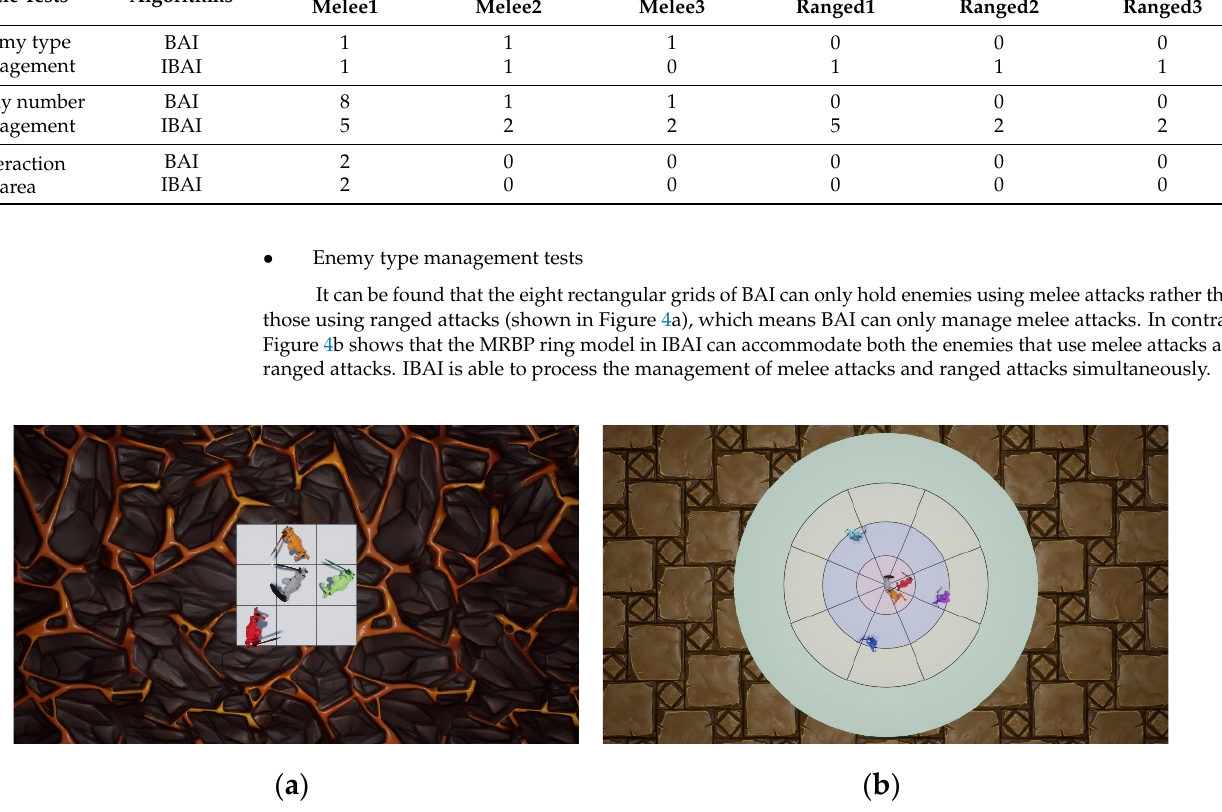
Figure 4. Tests for enemy types that can be managed. ( a ) BAI; ( b ) IBAI.